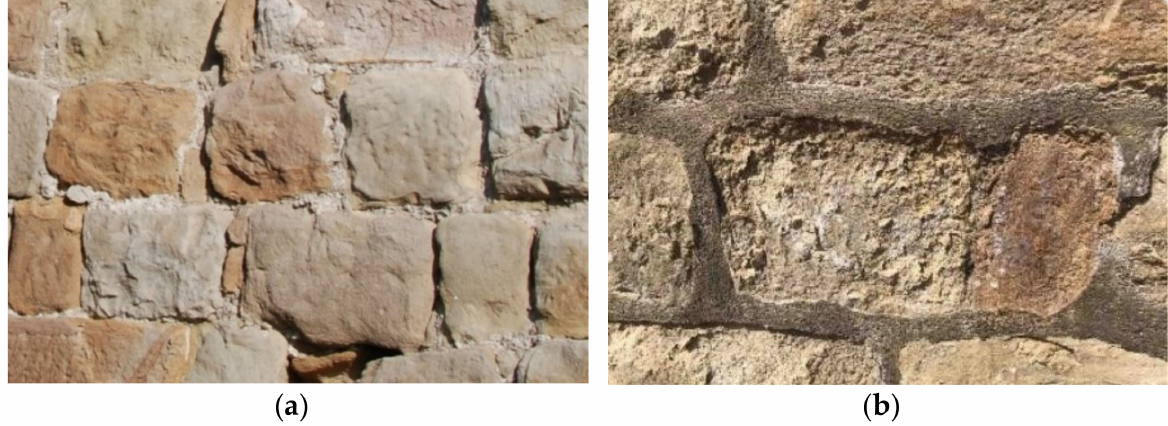
Figure 1. Malpractice of introducing cement-lime mortar in Serbia ( a ) before July 2012; ( b ) nine years after repair of the wall—July